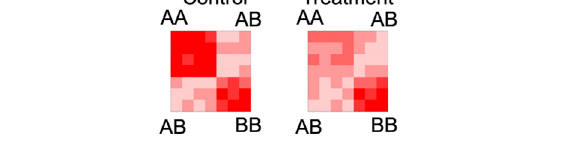
FIGURE 7 Illustrative example of how saddle plot analysis can detect changes in compartment interaction intensity. The example matrices from Figure 6 were used to demonstrate how resorting interactions can provide a useful